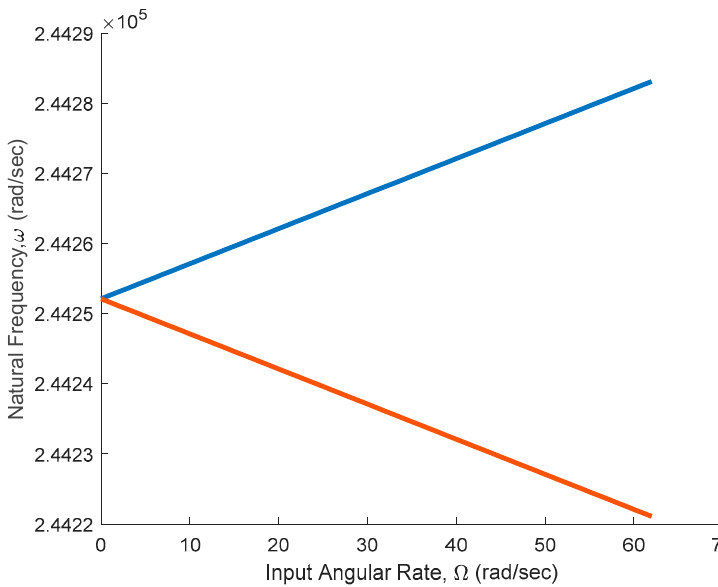
Figure 4. Natural frequency variations for rotating ring.